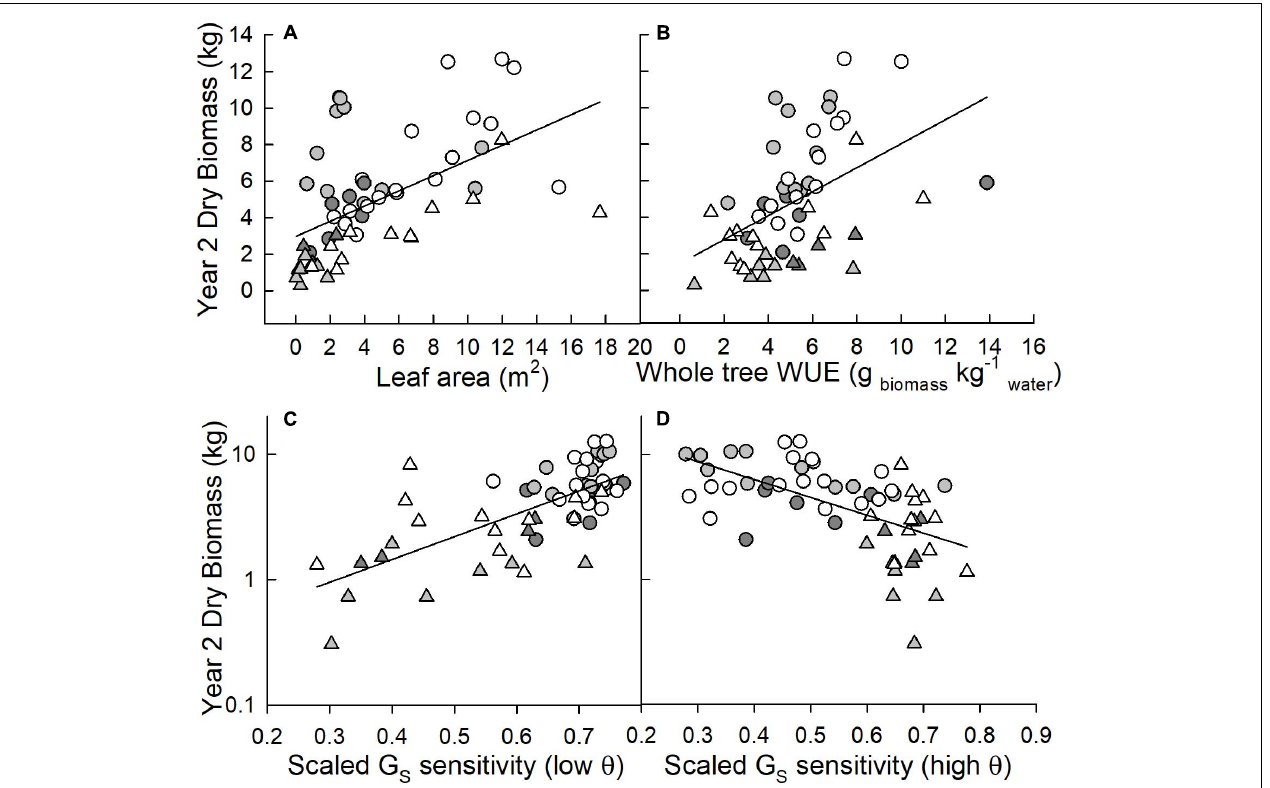
FIGURE 5 | Correlations between dry biomass measured after two growing seasons (kg; note the log scale on the lower graphs) and (A) leaf area measured at harvest (m 2 ), (B) whole-tree water use efficiency (g biomass kg − 1 water) and scaled canopy stomatal conductance (G S ) sensitivity at (C) low and (D) average to high soil moistures ( θ ; cm 3 cm − 3 ). The Coastal Plain site is presented as circles, the LMAV site as triangles. Eastern cottonwoods (D × D) are white symbols, D × M taxa are light gray, T × D taxa are dark